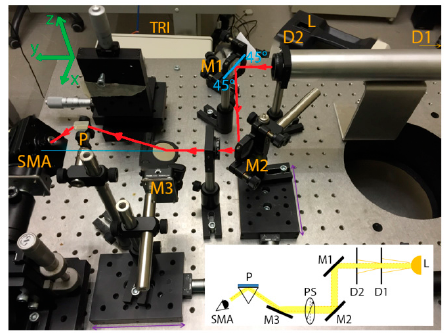
Figure 4. Picture of the optical setup for exciting and detecting SPRs. A schematic of the components of the optical setup is shown in the inset (bottom right). Polychromatic light (L) reaches the polarizer (PS) after passing through two diaphragms (D1 and D2) and two mirrors (M1 and M2). By means of a third mirror (M3) and a prism (P), the polarized light reaches the sensor (mounted with a holder on top of the prism) and excites the surface plasmons (SPs). SPR is detected with a spectrometer (SMA) which collects the polarized light reflected from the